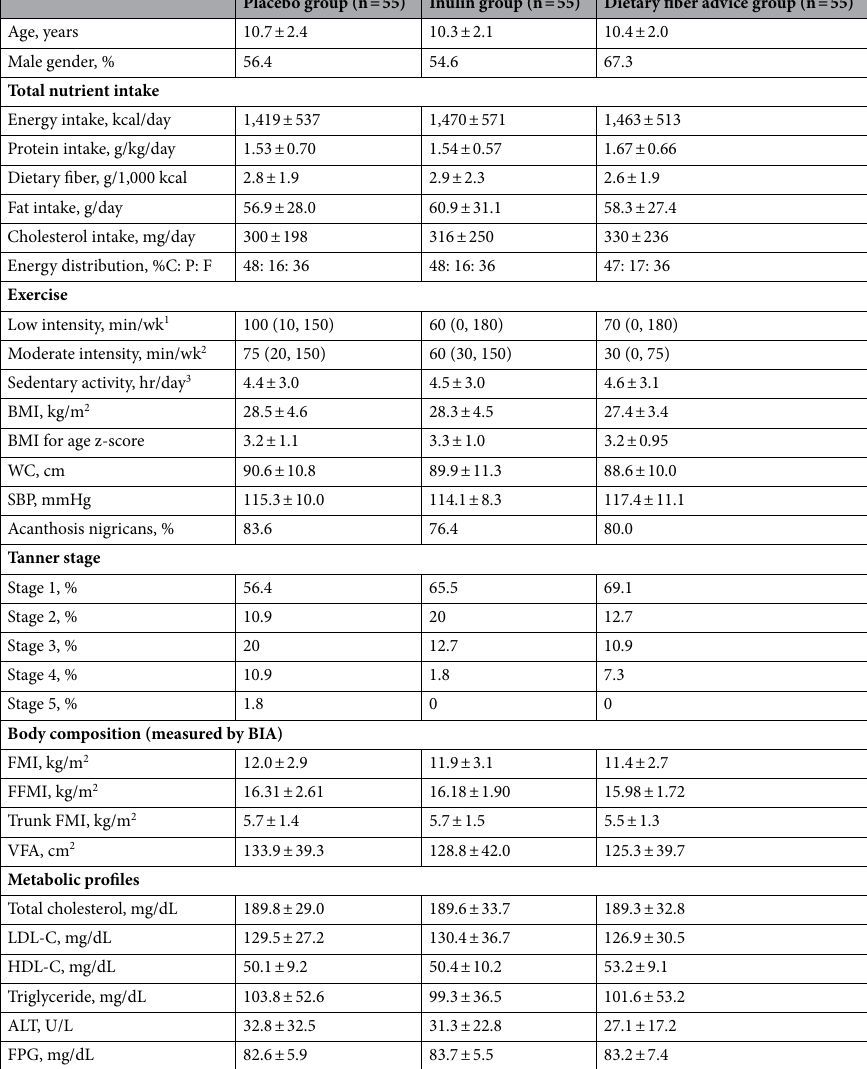
evaluate non-parametric variables, and Chi-square was used to evaluate categorical variables. No statistically significant between-group difference was demonstrated for all parameters. 1 Low intensity (min/wk) was walking from home to school or walking from one place to another for at least 10 min. 2 Moderate intensity (min/wk) was brisk walking or riding a bicycle continuously for at least 10 min. 3 Sedentary activity was defined as a type of lifestyle involving little or no physical activity. ALT, alanine aminotransferase; BIA, bioelectrical impedance analysis; C, cholesterol; FPG, fasting plasma glucose; FFMI, fat-free mass index = fat-free mass (kg)/ height (m 2 ); FMI, fat mass index = fat mass (kg)/height (m 2 ); SBP, systolic blood pressure; VFA, visceral fat area; WC, waist